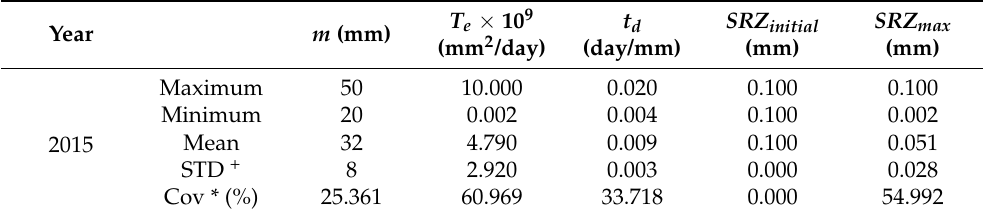
Table 2. Descriptive statistics of TOPMODEL parameter sets that were obtained during model calibration. Only parameter sets with an NSE of at least 0.5 were considered. Year